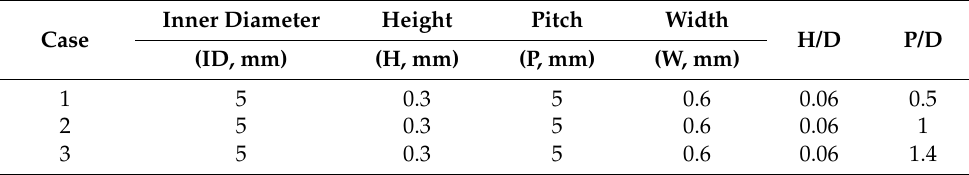
Figure 1. Configurational parameters of the corrugated tubes. Table 1. Dimensions of the corrugated